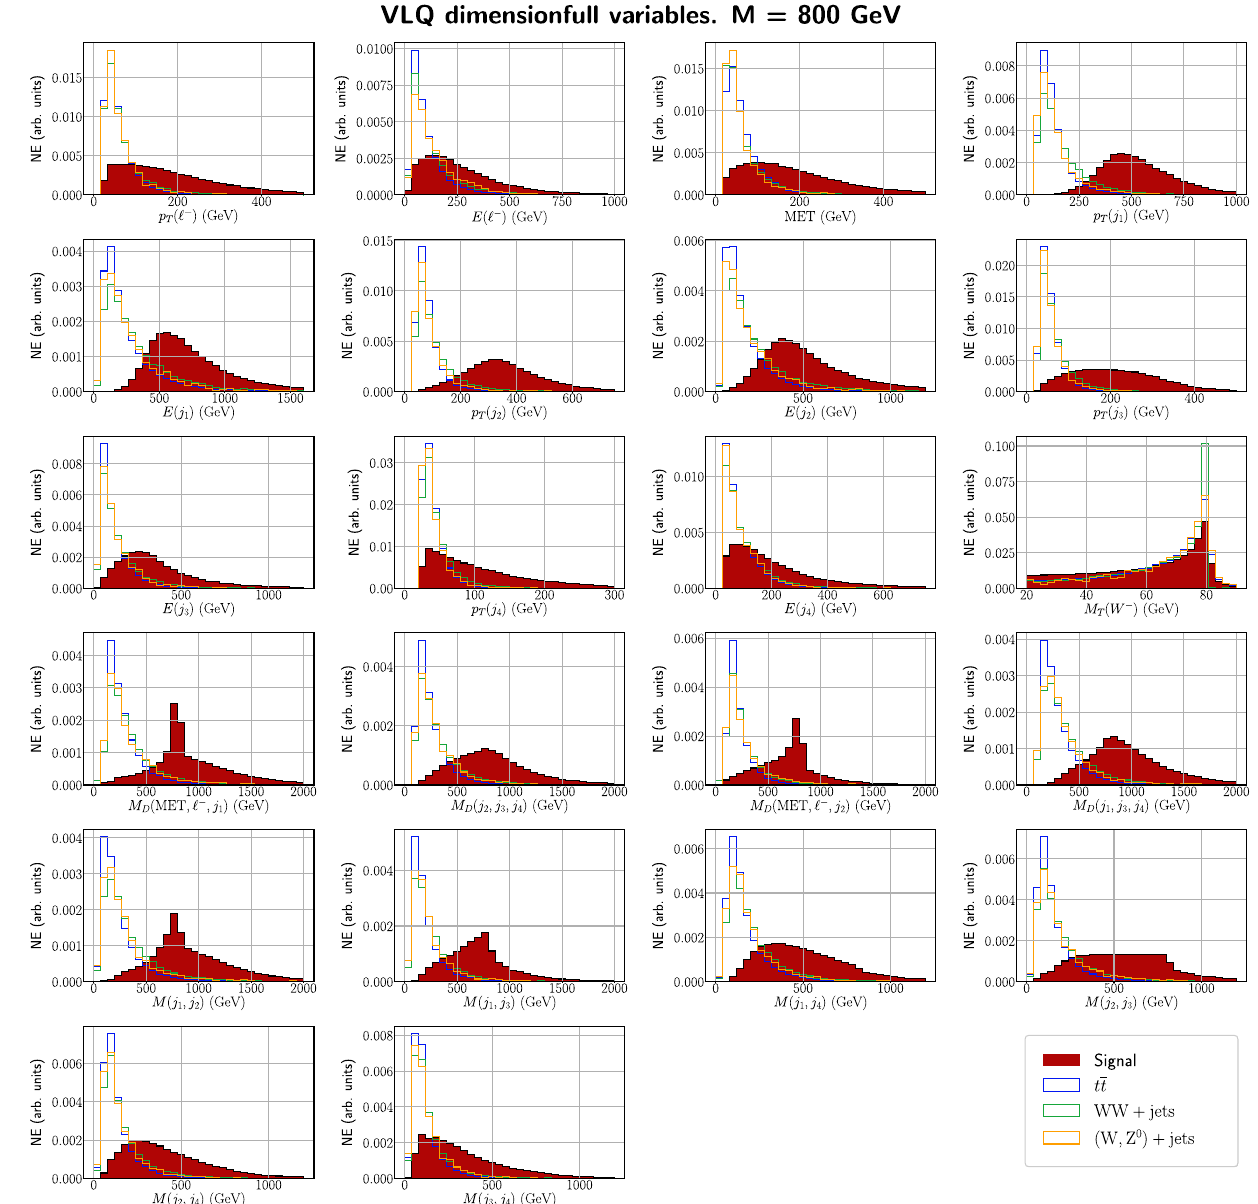
Fig. 7 The dimensionful kinematic distributions (in units of GeV) for pair-production of 800 GeV VLQs. From top to bottom and left to right, we have p T ((cid:7) − ) , E ((cid:7) − ) , MET, p T ( j 1 ) , E ( j 1 ) , p T ( j 2 ) , E ( j 2 ) , p T ( j 3 ) , E ( j 3 ) , p T ( j 4 ) , E ( j 4 ) , M T ( W − ) , M ( W +